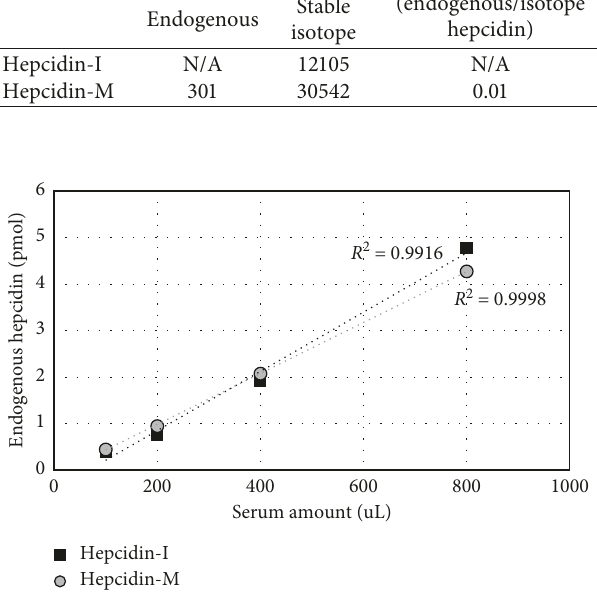
Figure 4: The graph shows correlation between serum amount ( μ L) and endogenous hepcidin (pmol). Hepcidin amount was calculated using the peak area of SI-hepcidin (100pmol) acquired from SRM